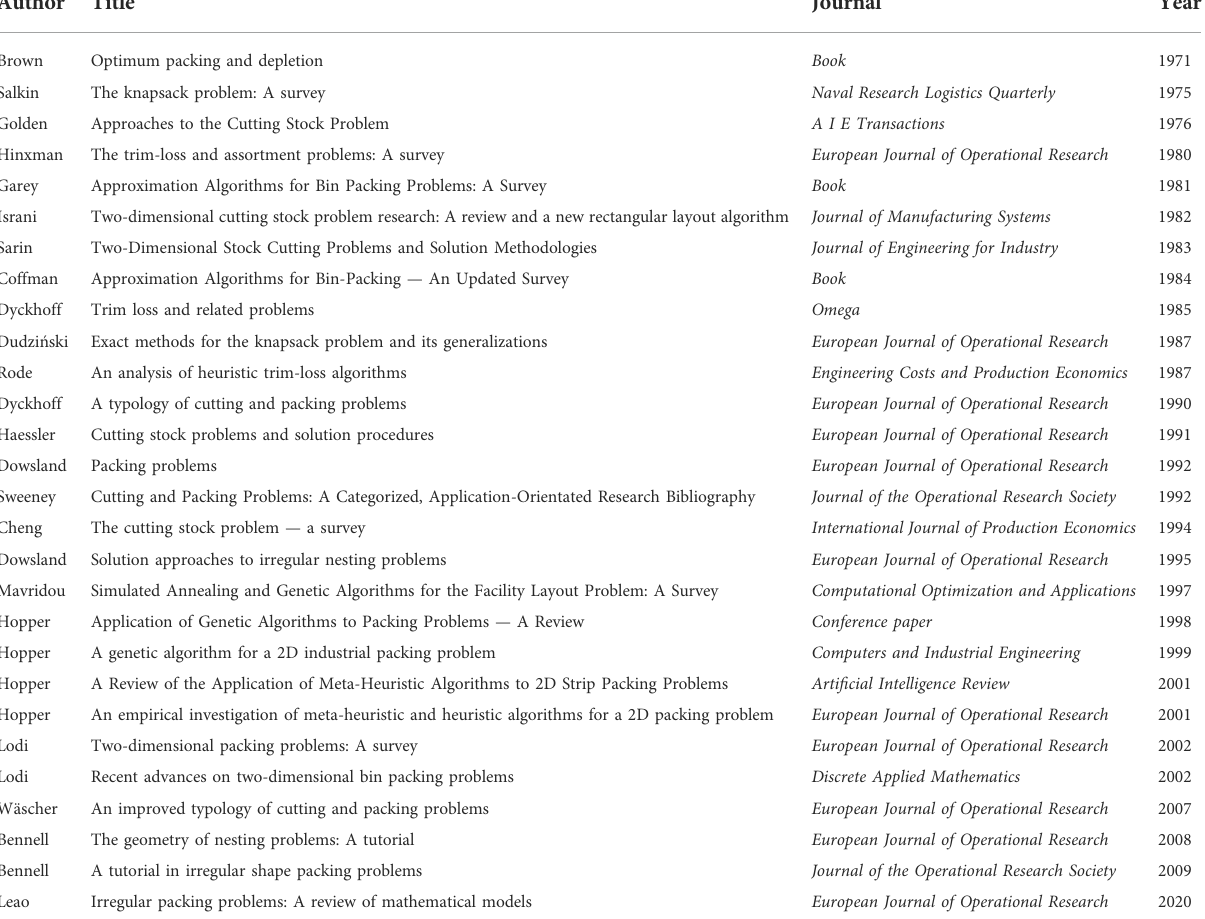
TABLE 1 Review literature in the fi eld of cutting and packing